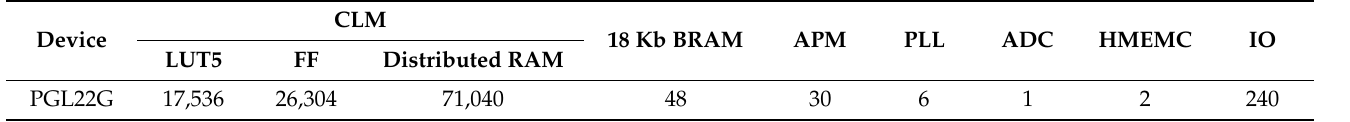
Table 1. List of resources for the PGL22G FPGA.